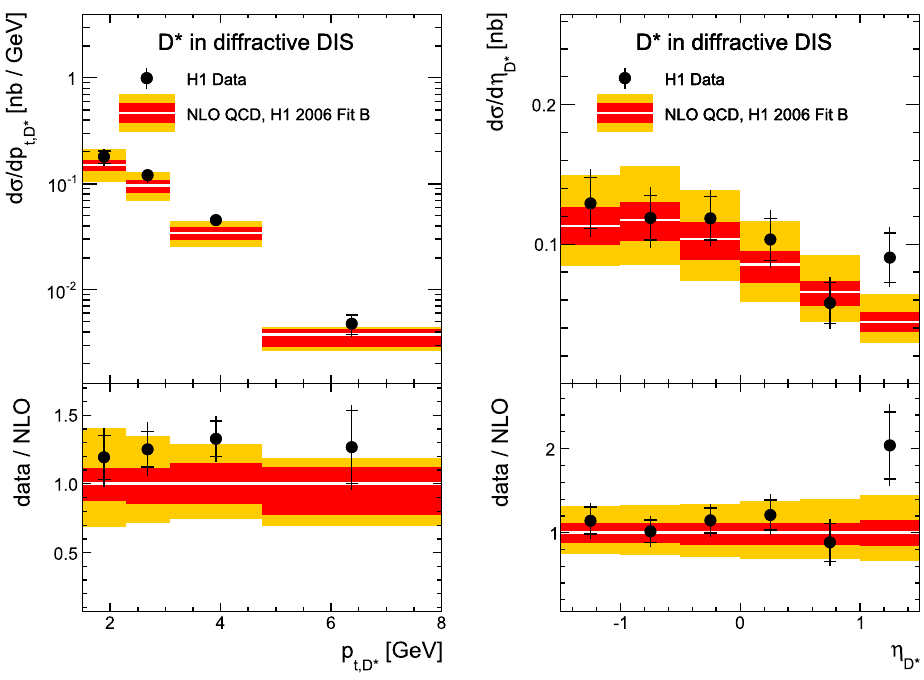
Fig. 5 Bin averaged single-differential D ∗ cross sections as a function of the diffractive variables log 10 ( x IP ) and z obs in the caption of Fig. 4